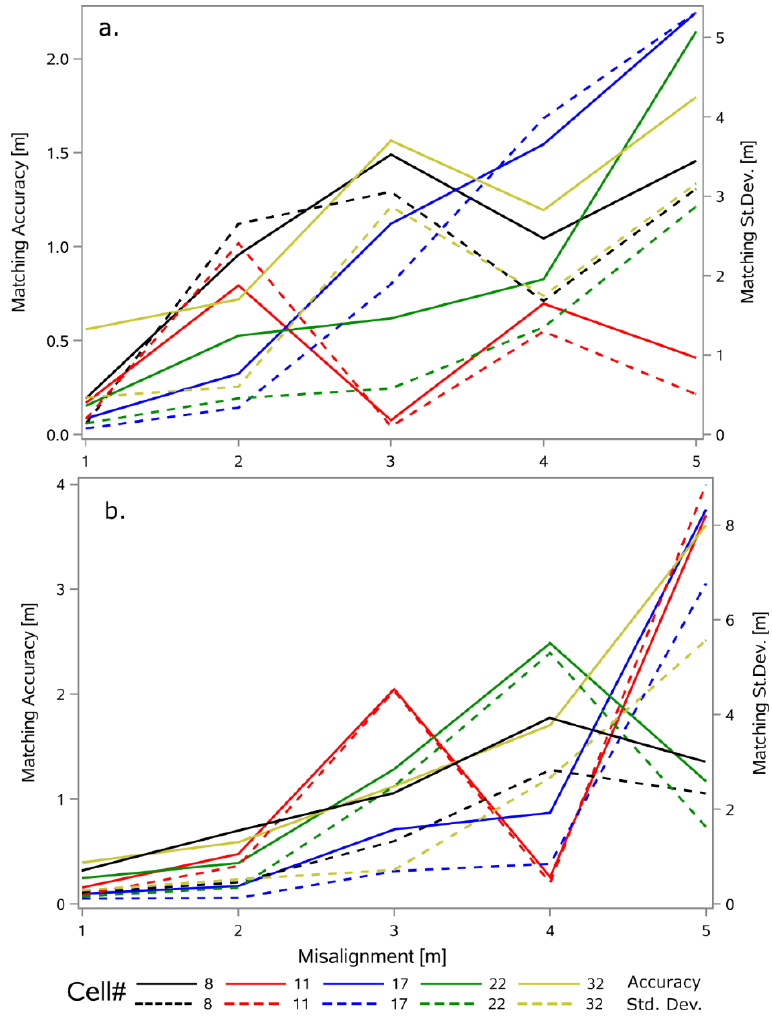
Figure 9. Impact of stem misalignment on the accuracy of tree matching for the five grid-cells used in geo-referencing all the trees; ( a ) 70% of the trees are found in the above and below tree segmentations; ( b ) 80% of the trees are found in the above and below tree segmentations.